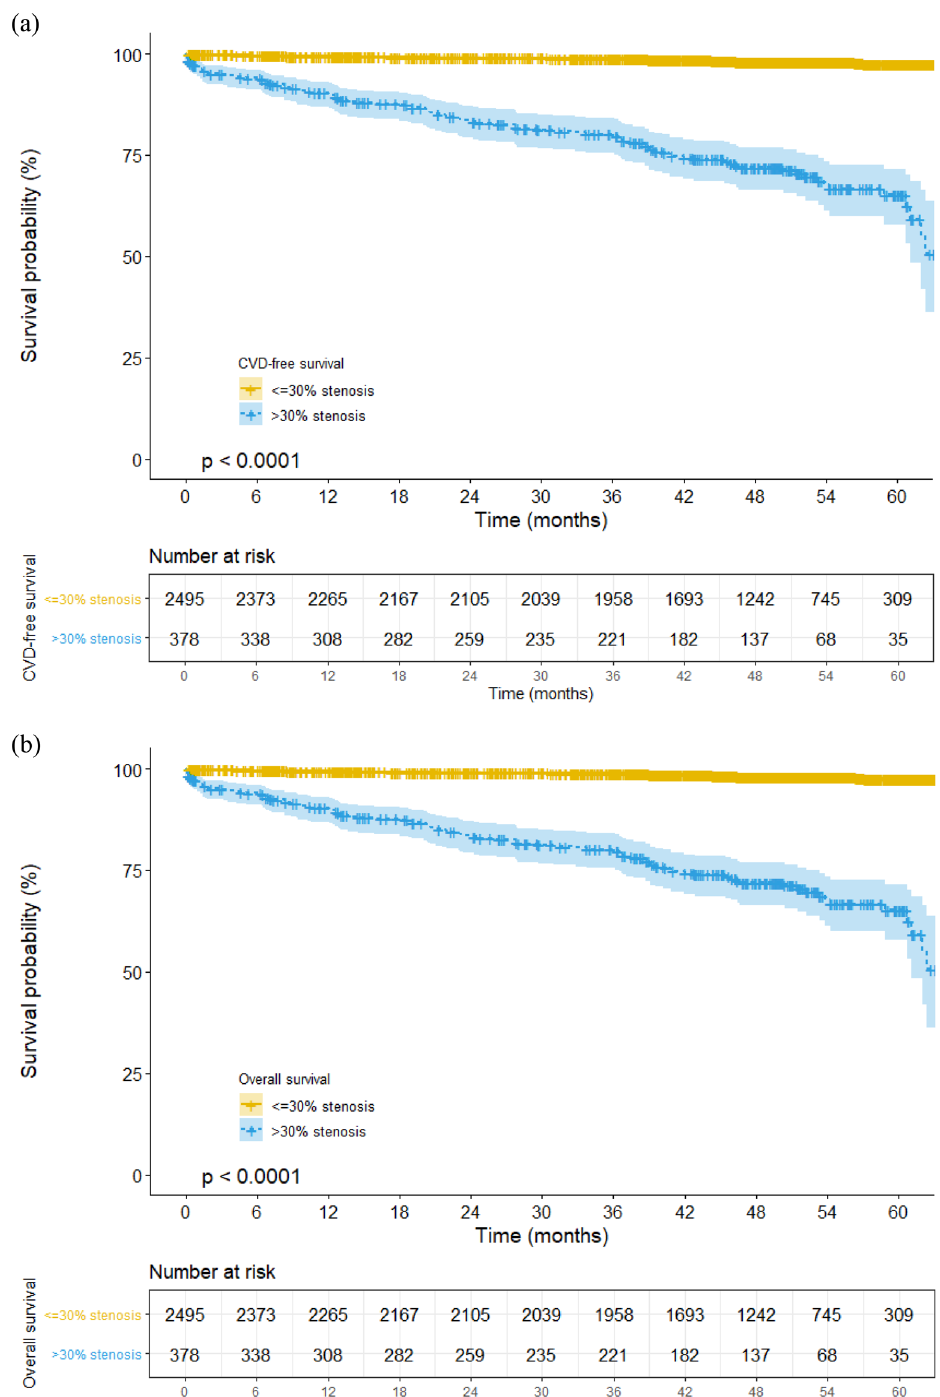
Figure 2. Cumulative survival rate/time. ( a ) New-onset cardiovascular disease-free survival rate and ( b ) overall survival